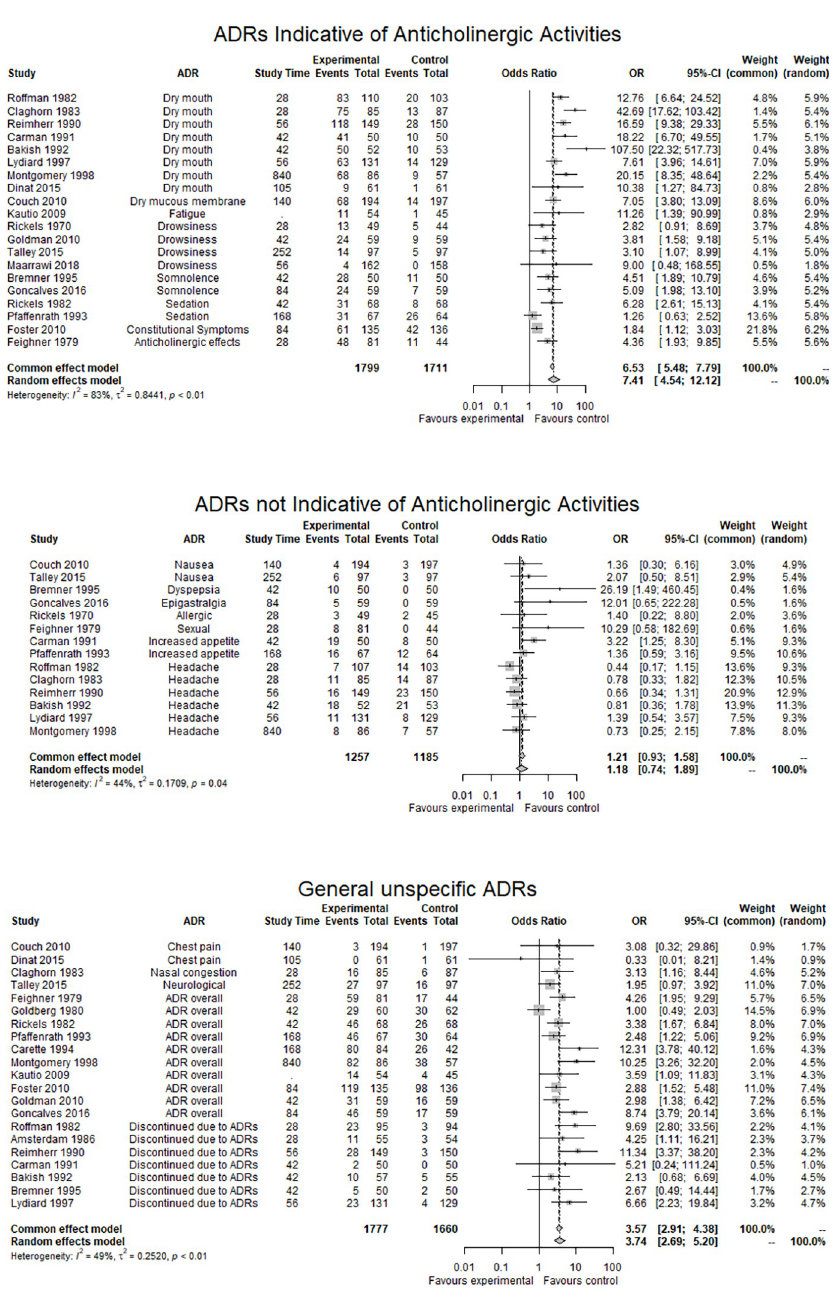
Fig 2. Forest plots of primary